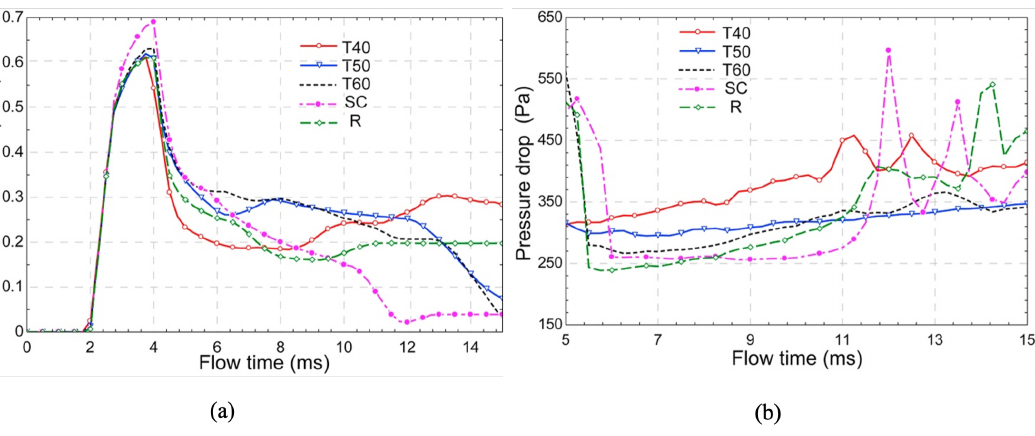
Figure 4. Variation of ( a ) the water content within control volume and ( b ) the two-phase pressure drop during the flow time of 5–15 ms for different channel cross-section geometries